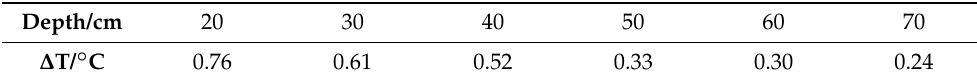
Figure 5. Submersible temperature difference infrared image. Where ( a ) was imaged at a temperature difference of 18 degrees and ( b ) was imaged at a temperature difference of 11 degrees. Table 2. Statistics of IR wake rising in calm water.